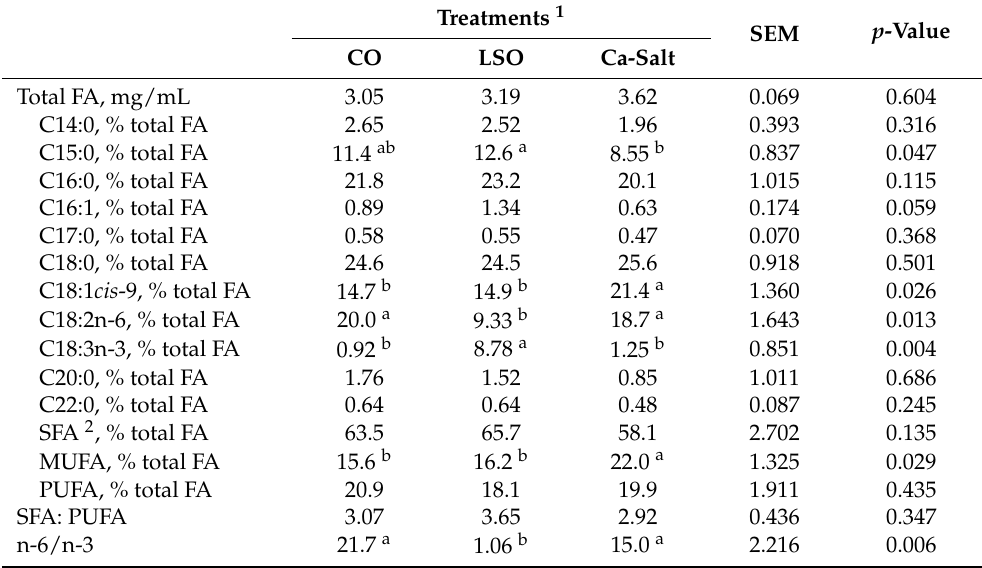
Table 3. Effects of oil source supplementation containing essential fatty acid on fatty acid profile of rumen buffer just before incubation.